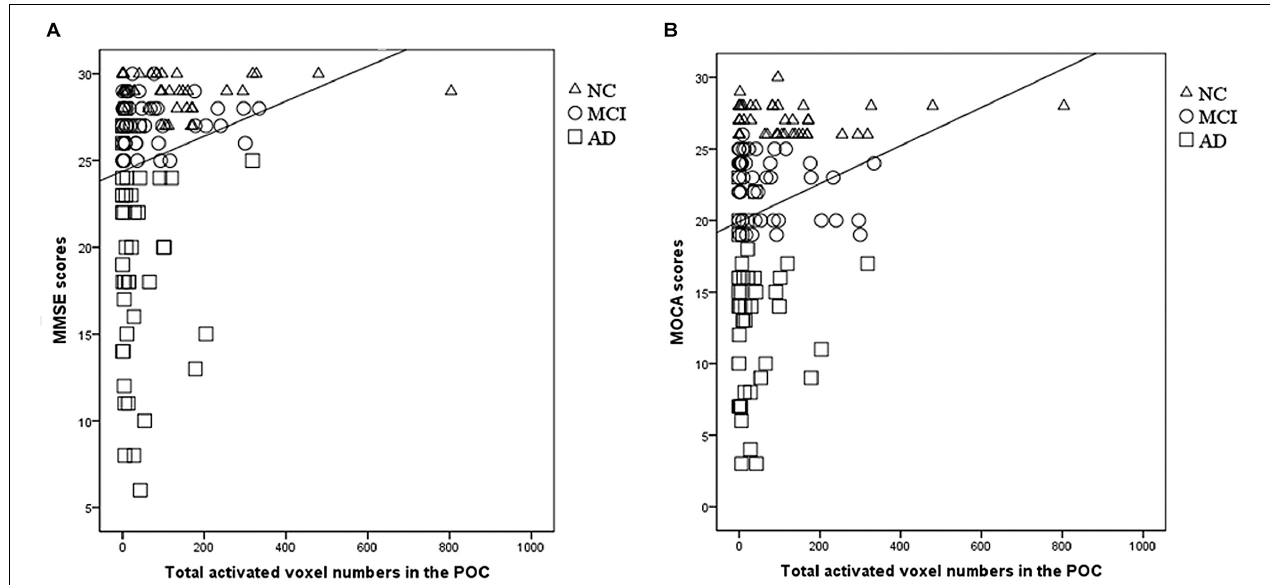
FIGURE 3 | The correlation between the POC activation and MMSE/MOCA scores. (A) There was a significantly correlation between the total activated voxel numbers in the POC and the MMSE scores ( r = 0.207, P = 0.016). (B) There was a significantly correlation between the total activated voxel numbers in the POC and the MOCA scores ( r = 0.226, P = 0.009). From this figures, the overlapping distribution of POC activation for NC, MCI, and AD subjects could also be found, which implied it’s impossible to setup a threshold to separate these groups.